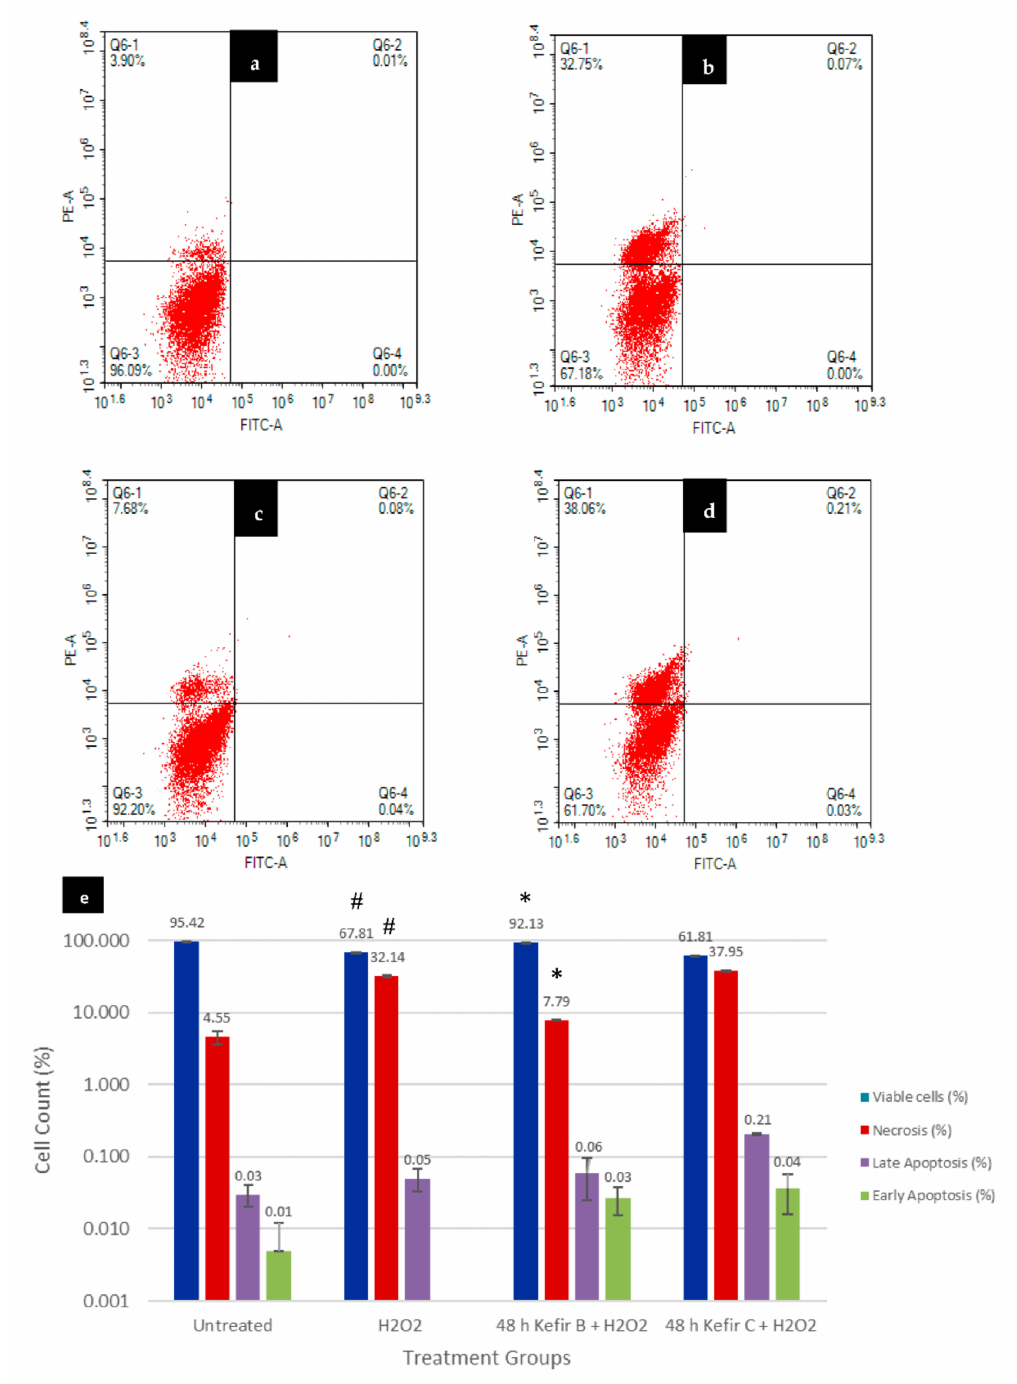
Figure 5. Flow cytometry Annexin V-FITC analysis of differentiated SH-SY5Y cells where ( a ) un- treated SH-SY5Y cells, ( b ) 24 h H 2 O 2 -exposed cells, ( c ) 48 h Kefir B pre-treated plus 24 h H 2 O 2 - exposed cells, ( d ) 48 h Kefir C pre-treated plus 24 h H 2 O 2 -exposed cells, and ( e ) quantification analysis of cells at death. The experiment was carried out in triplicates and values are presented in means ± SD. # p < 0.0005 versus untreated, * p < 0.0005 versus H 2 O 2 . A one-way ANOVA was conducted to determine the significance of 48 h Kefir B and Kefir C pre-treatment on H 2 O 2 -induced cellular apoptosis. The one-way ANOVA test showed statistically significantly difference in the percentage of viable cells F(3,7) = 2438.178, p < 0.0005, and necrosis cells F(3,7) = 2534.183, p < 0.0005 found in the dot plot. Tukey HSD post-hoc analysis revealed that the increase in the percentage of viable cells (%) when compared to H 2 O 2 treated cells to untreated control cells (27.607, 95% CI